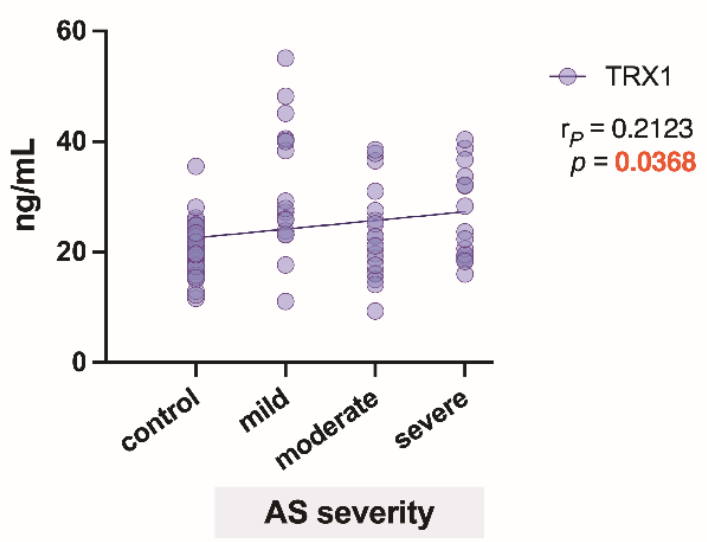
Figure 3. Correlation and regression line of thioredoxin-1 (TRX1) regarding AS severity degrees. r P —Pearson’s correlation coefficient.